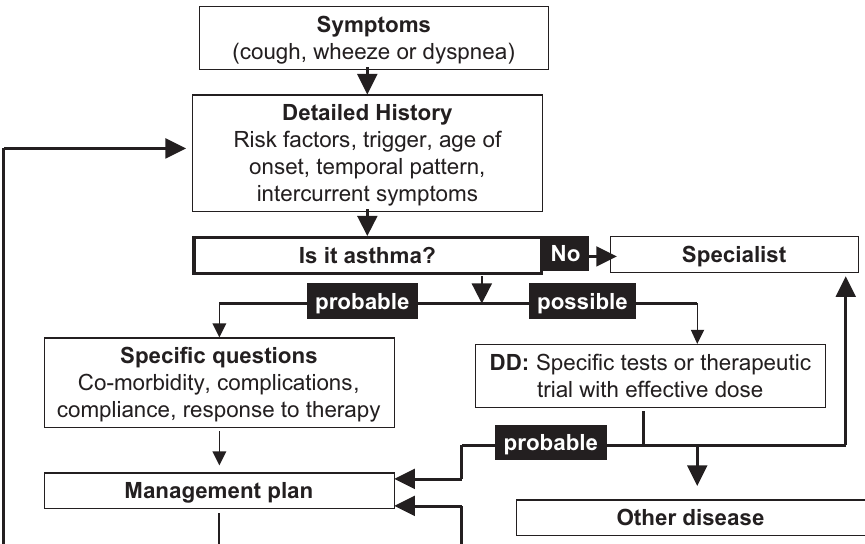
Diagnosis of asthma syndrome in children (from [3], modified from